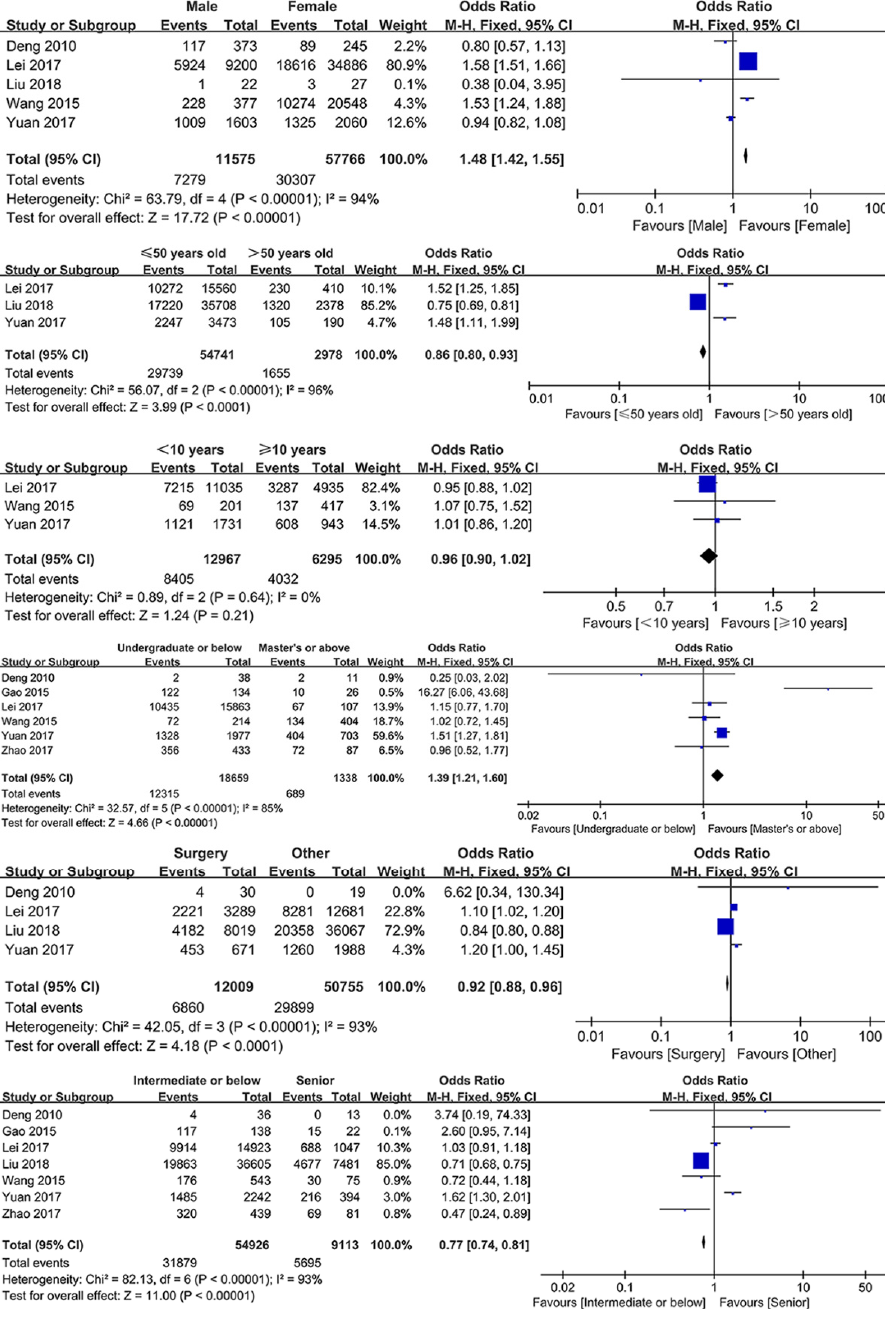
Figure 2. Forest plots of healthcare worker-related determinants.